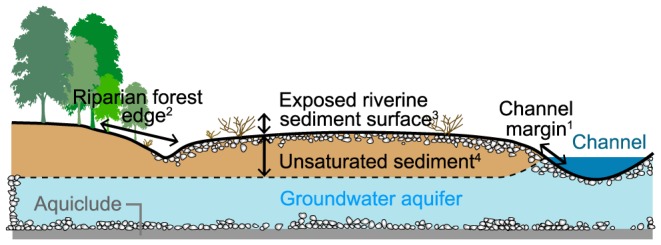
Location of the four investigated floodplain ecotones.Cross-section of a floodplain gravel bar indicating the location of the four consequential ecotones included in the study: 1the channel margin (aquatic – terrestrial ecotone), 2the edge of the riparian forest (forest – active floodplain ecotone), 3the sediment surface (sediment – air ecotone), and 4the unsaturated interstitial sediment below the sediment surface and above the groundwater table (sediment – groundwater ecotone).